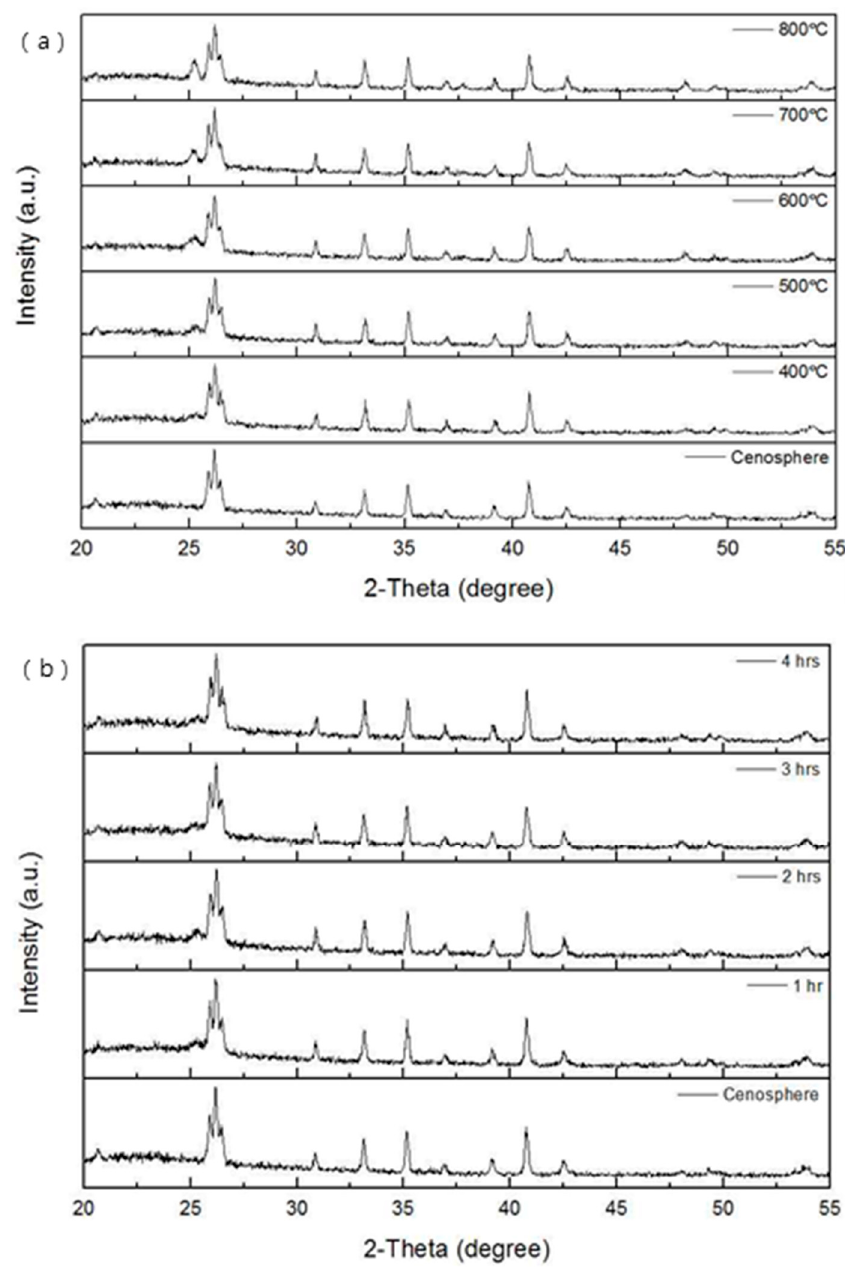
Figure 4. Phase structures of photocatalytic media under di ff erent conditions: ( a ) Calcination temperatures, and ( b ) calcination times (prepared in the optimized reaction conditions (amount of water = 2.4 mL, amount of precursor = 12 mL, aging time = 60 min, reaction pH = 1, amount of beads = 15 g)).